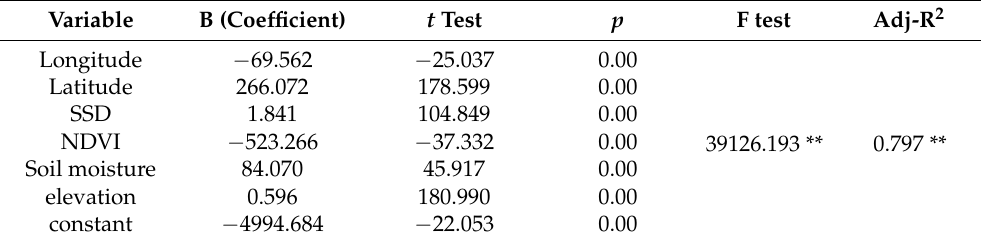
Table 4. Parameters of the multiple linear regression model constructed by GFI and explanatory vari-